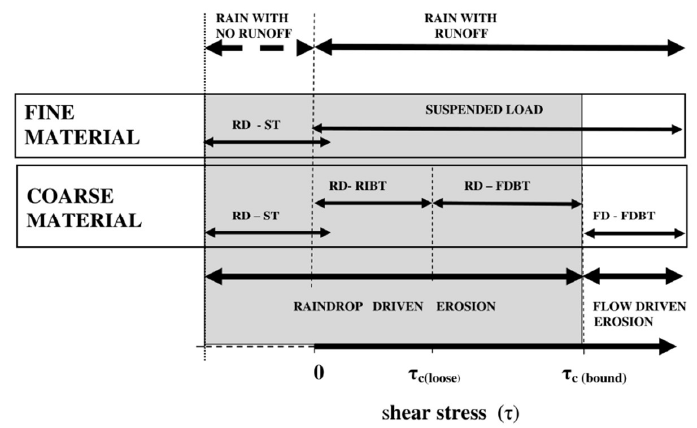
Figure 13. Schematic diagram of the detachment and transport systems that operate in rainfall erosion. RD = raindrop detachment, FD = flow detachment, ST = splash transport, RIBT = raindrop-induced bedload transport (raindrop-induced saltation, raindrop-induced rolling), FDBT = flow-driven bedload transport (flow-driven saltation, flow-driven rolling).